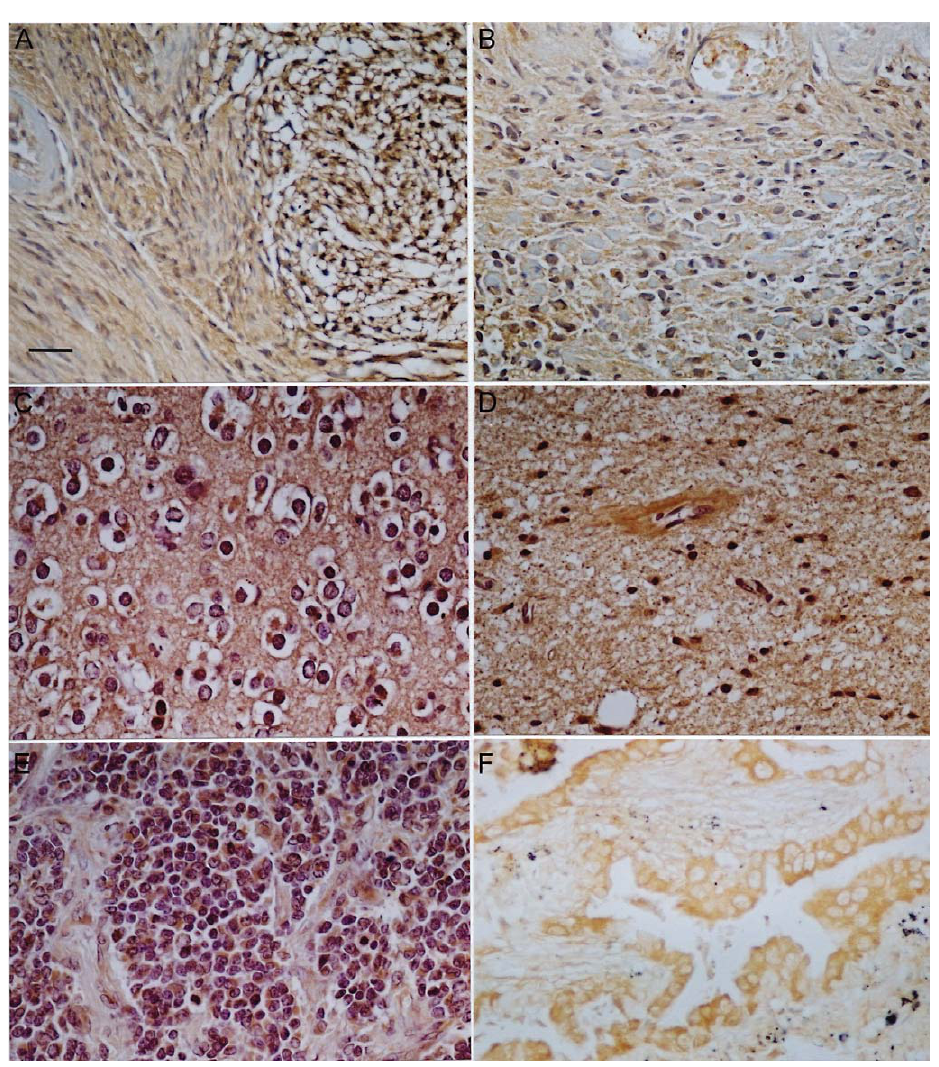
Fig. 3. WOX1 expression in schwannoma (a, b), astrocytoma/gliobalstoma and ependymoma tumors (c–f). The spindle cells with very small, dark nuclei and wavy cytoplasmic processes in schwannoma obtained from the cerebellopontine angle were immunostained intensely compared to fibroblast-like tumor cells with elongated nuclei (a). Moderate expression was present in another case with diverse cellular patterns, located between negative-staining collagenous and sclerosing tissues (b). In astrocytoma cases, the levels of WOX1 were relatively low in the low- grade astrocytomas, such as pilocytic type (data not shown). In the case with oligodendroglioma and astrocytoma mixed tumors (grade II), immunostaining was moderately present in the matrix of non-proliferating round tumor cells (c, d). WOX1 was also strongly expressed in the anaplastic subtypes (e). In the ependymoma case (f), WOX1 expression was expressed in the cytosol of cyst-lining cells. Bar=50 (cid:1) m.